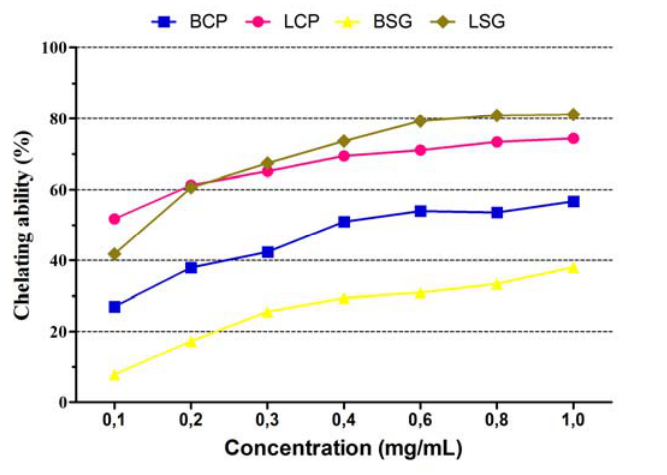
Figure 2. The chelating capacity of the CEE of the bark and leaves of Caesalpinia pyramidalis Tul. e Sapium glandulosum (L.) Morong. BCP = bark of C. pyramidalis ; LCP = leaves of C. pyramidalis ; BSG = bark of S. glandulosum ; LSG = leaves of S. glandulosum